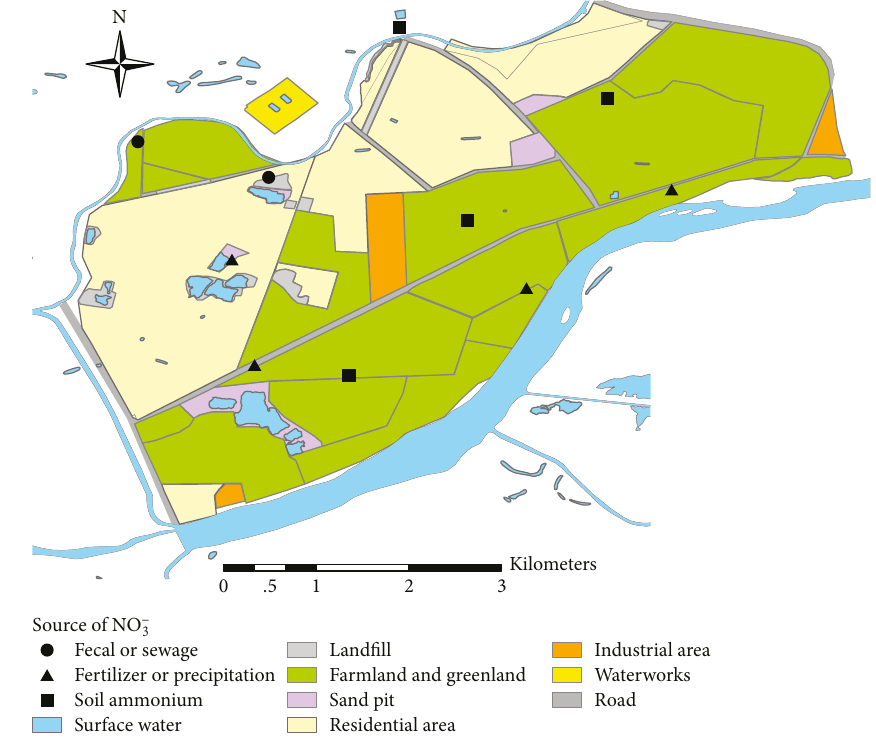
Figure 7: Sample point distribution and its nitrate source of soil samples in September